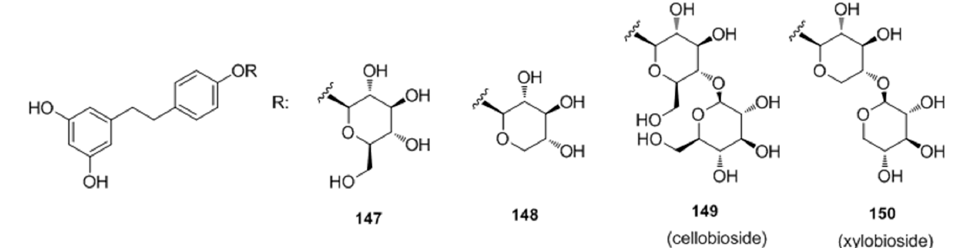
Figure 29. Structures of dihydroresveratrol glucosides.